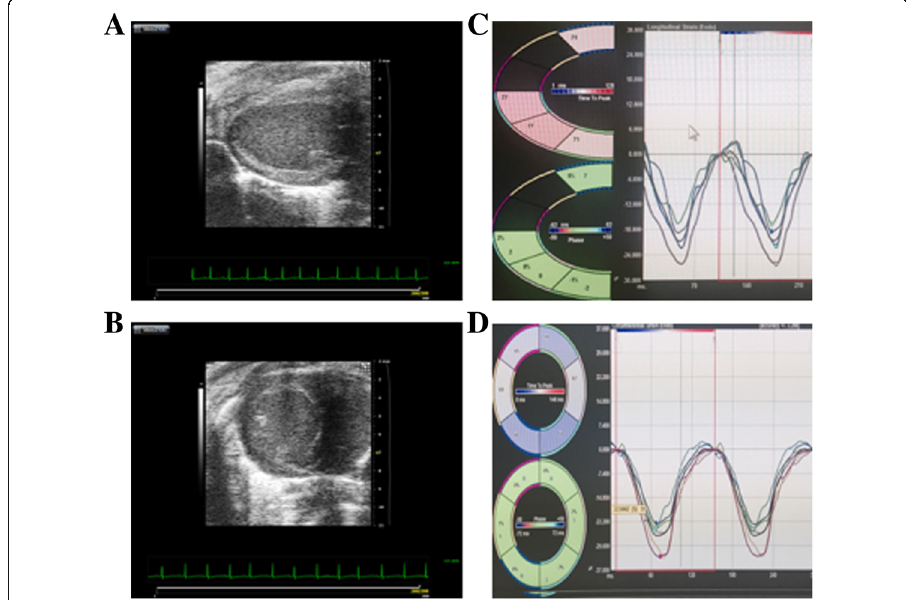
Fig. 1 Strain analysis by echocardiogram post-processing software (VevoStrain, FUJIFILM VisualSonics Inc.). The parasternal long access view ( a ) was used to calculate the longitudinal strain (LS, %) ( b ) and the longitudinal strain rate (LSR, 1/sec). The parasternal short axis view ( c ) was used to calculate the circumferential strain (CS, %) ( d ) and circumferential strain rate (CSR,